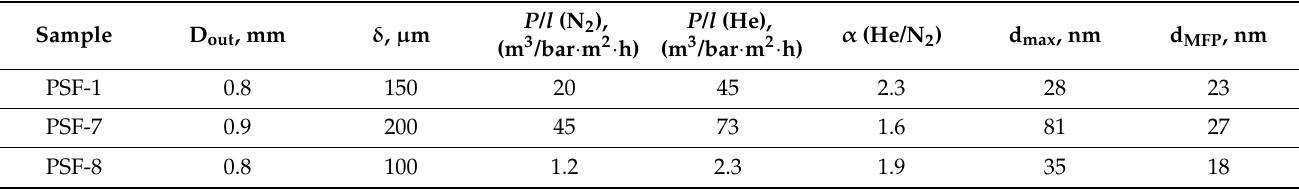
Table 5. Properties of the hollow fiber membrane obtained in the work.